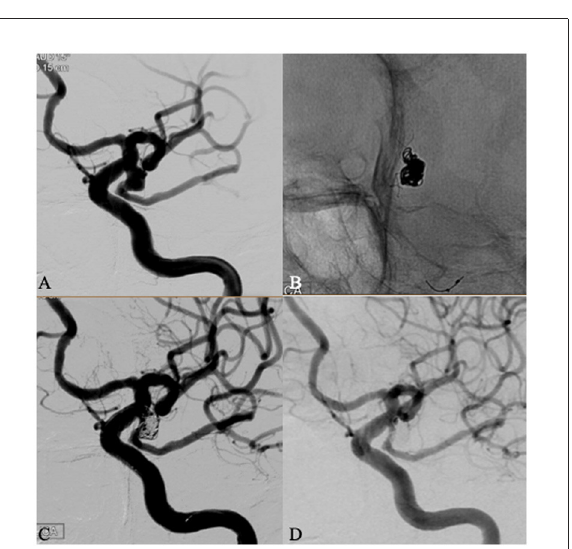
FIGURE2 A 64 years old female patient with an incidental fatal posterior communicating (PCom) artery aneurysm. Left internal carotid artery (ICA) angiography showed a PComA aneurysm with wide neck located at fatal posterior communicating artery (A) . The aneurysm was coiled assisted by a Leo baby stent deployed in the PCom artery across the aneurysm neck. The proximal end of the stent covered the neck of the aneurysm satisfactorily and was detached in the ICA without touching the opposite wall (B) . Immediate angiography after procedure showed a Raymond 3 occlusion (C) . The patient was discharged without deficit. Follow-up angiography 6 months later showed a complete occlusion of the aneurysm and patent P-com aneurysm (D)